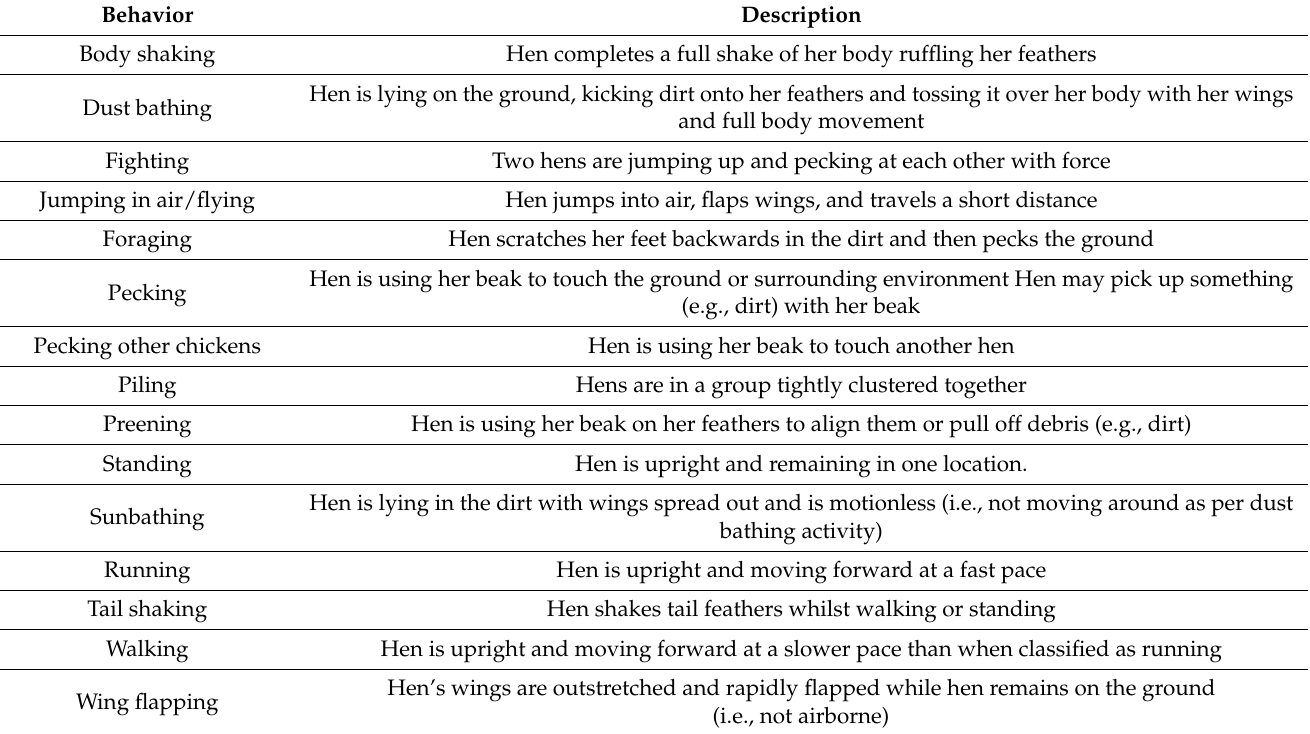
Table 1. Ethogram of the behaviors observed for each hen whilst out on the range at 50 weeks of